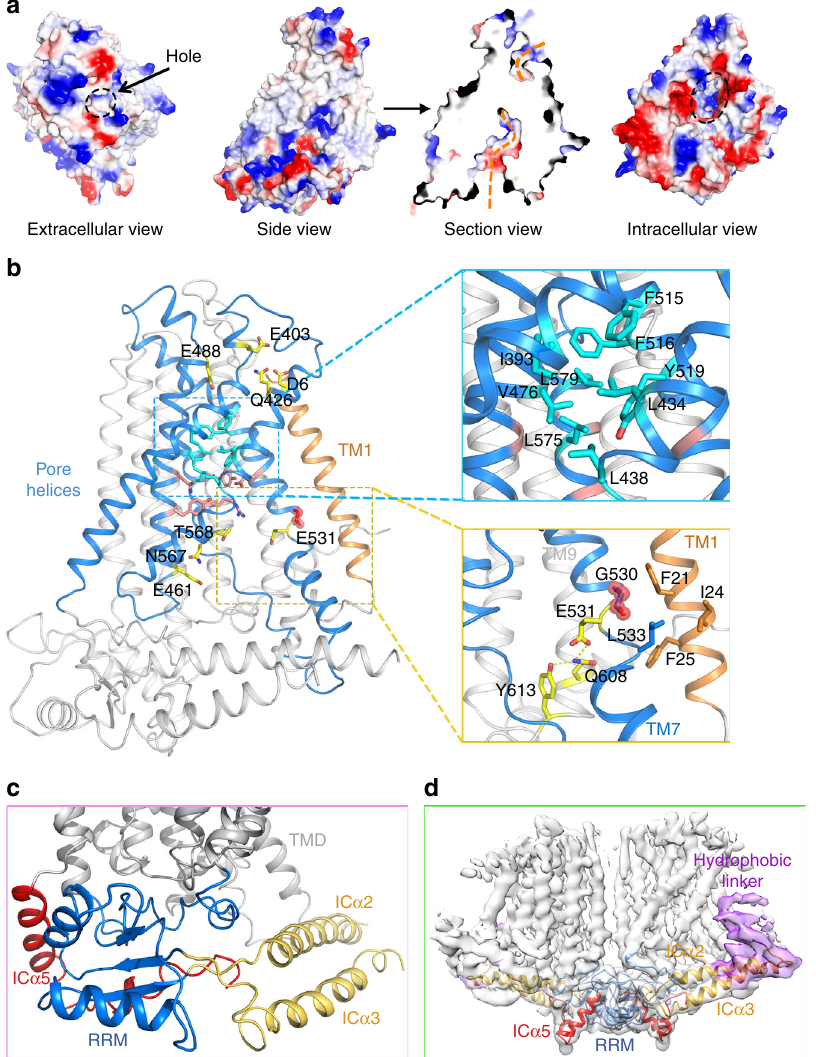
Fig. 4 The ion conduction pore of AtOSCA1.2. a Surface view of the ion conduction pore of AtOSCA1.2. The extracellular part of the pore is relatively small as indicated by a black dashed-line circle. The conduction pore is in a closed state and blocked in the middle as shown in the section view. It is accessible from the cytoplasmic side through a hole as indicated in the intracellular view. b Pore-lining residues of AtOSCA1.2. The extracellular part of the pore contain several negatively charged or polar residues, as shown in sticks coloured yellow. The pore is constricted by hydrophobic residues in the middle (coloured cyan), as shown in a zoom-in view. The hinge region on TM7 is also shown in a zoom-in view. The hinge residue, G530, is shown in spheres. E531 of AtOSCA1.2 forms a triad with Q608 and Y613 via hydrogen bonds. The inner part of the conduction pore contains several negatively charged or polar residues, like E461, N567 and T568, as shown in sticks. c The cytosolic domain of AtOSCA1.2 contains an RNA recognition motif (RRM, coloured blue), a short helix after TM11 (IC α 5, coloured red), and two long helices that lie parallel to the membrane plane (IC α 2 and IC α 3, coloured yellow). d The electron density for the linker region between IC α 2 and IC α 3 in a 5 Å low-pass fi ltered map (coloured purple). This region shows a high degree of fl exibility and protrudes into the membrane like an